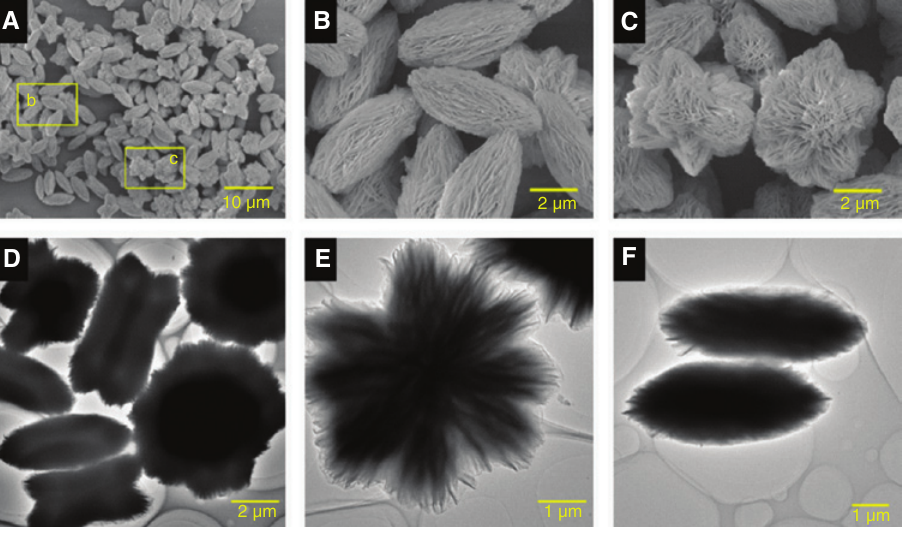
-HL. Reproduced from [137] with permission from 2